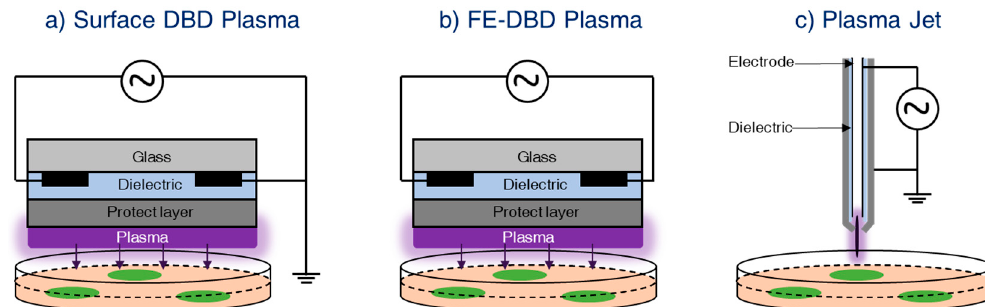
Figure 2. Typical structures of non-thermal DBD plasma and plasma jet devices at atmospheric pressure. ( a ) Surface DBD plasma; ( b ) FE ‐ DBD plasma; and ( c ) plasma jet.